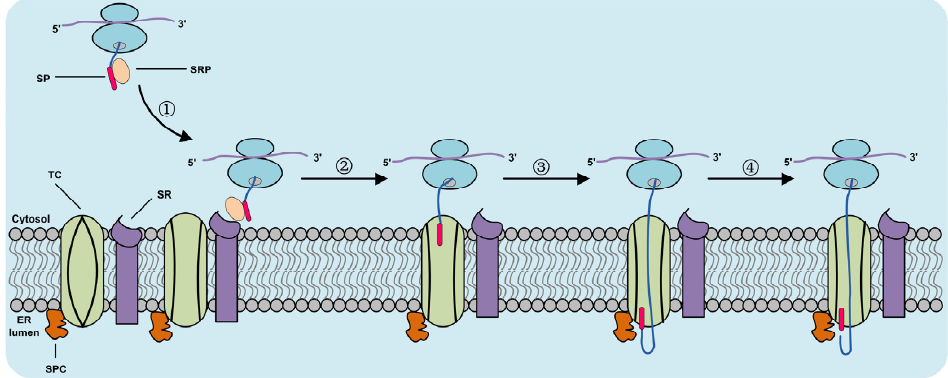
Figure 4. Proposed secretion pathway of SARS-CoV-2 spike protein. 1 (cid:13) New polypeptide-SRP- ribosomal complex binding to SR on ER membrane. 2 (cid:13) SRP separates from its receptors and promotes the tight binding of ribosomes and ER membranes to protein translocon channel. 3 (cid:13) The extended polypeptide passes through the membrane structure into the ER cavity as translation continues. 4 (cid:13) The signal peptidase inside the ER membrane cavity cleaves the signal peptide after recognizing the signal peptide cleavage site of the polypeptide, and the remaining polypeptides continue to undergo co-translational translocation through the ER membrane. SP: signal peptide. SRP: signal recognition particle. SR: signal receptor. TC: translocon channel. ER: endoplasmic reticulum. SPC: signal peptidase